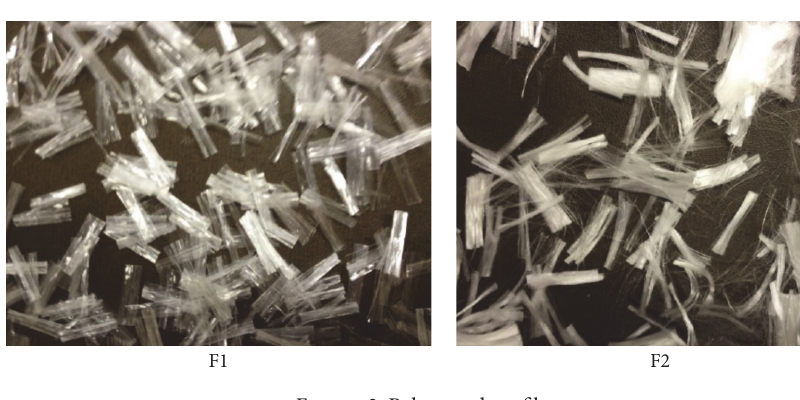
Figure 2: Polypropylene